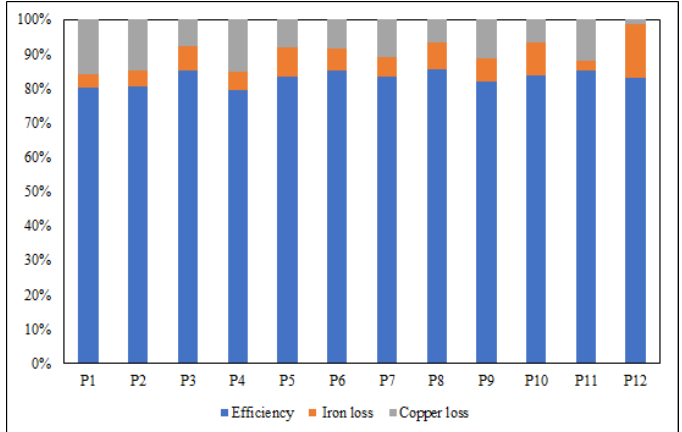
Figure 17. Efficiency at different